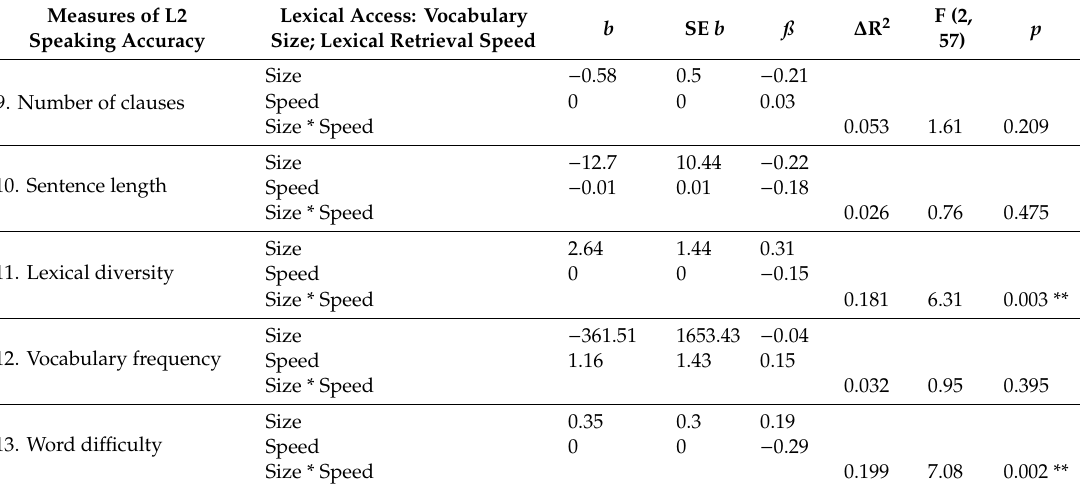
Table 6. Prediction of L2 speaking performance by lexical